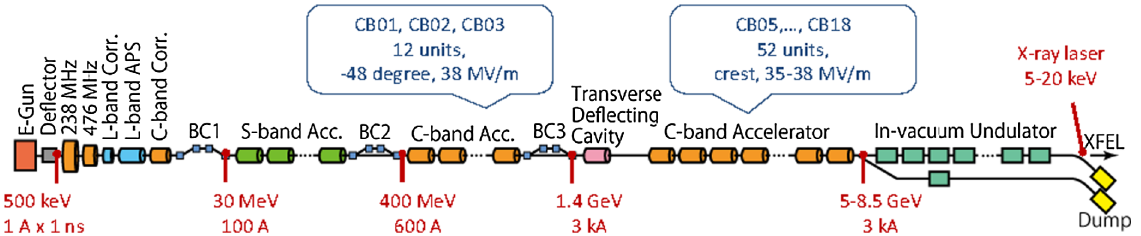
FIG. 1. Schematic of the SACLA accelerator, and the typical operation parameters for the electron beam and the C -band accelerator units. CB01, CB02, … are the names of the C -band accelerator sections, which consist of four accelerator